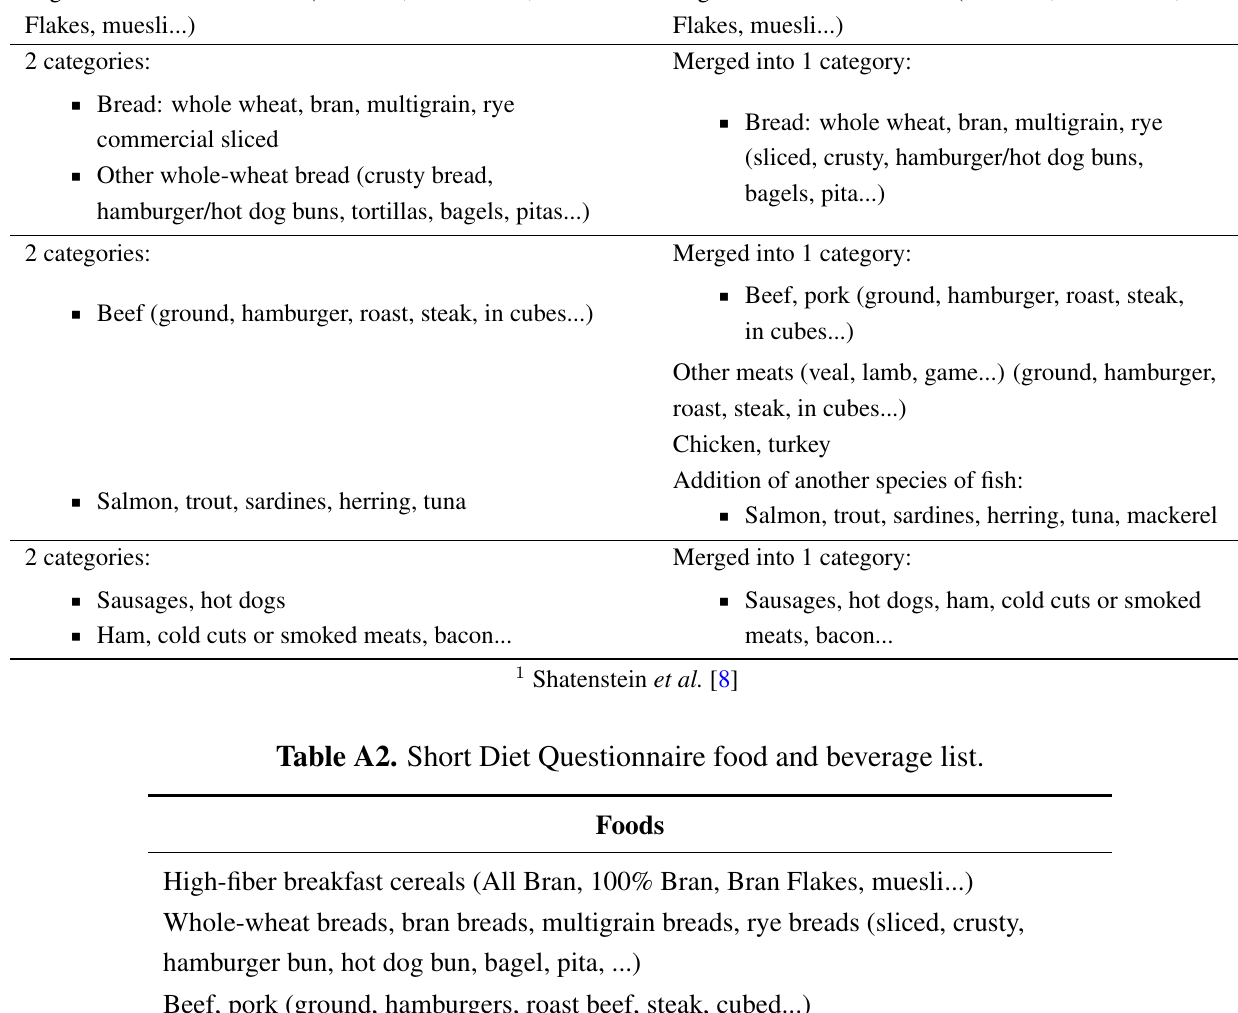
hamburger bun, hot dog bun, bagel, pita,